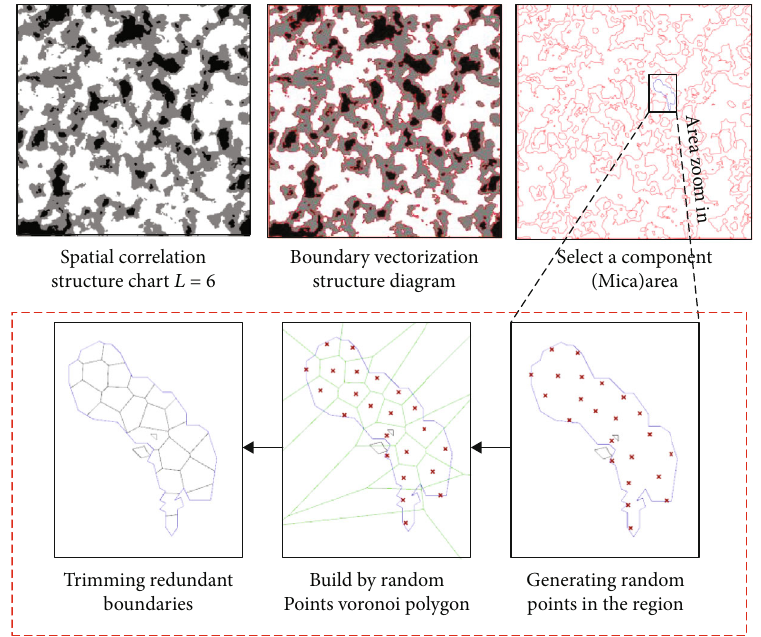
Figure 4: Generation diagram of the internal crystal structure in a certain